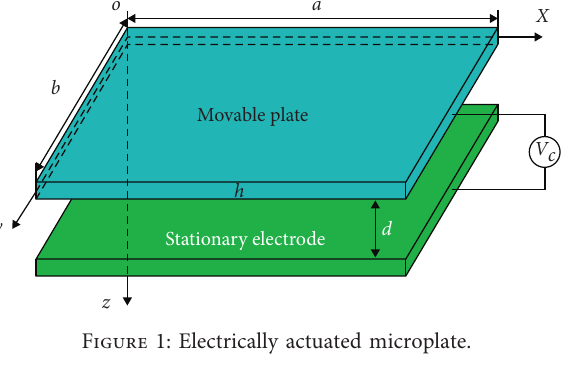
Figure 1: Electrically actuated